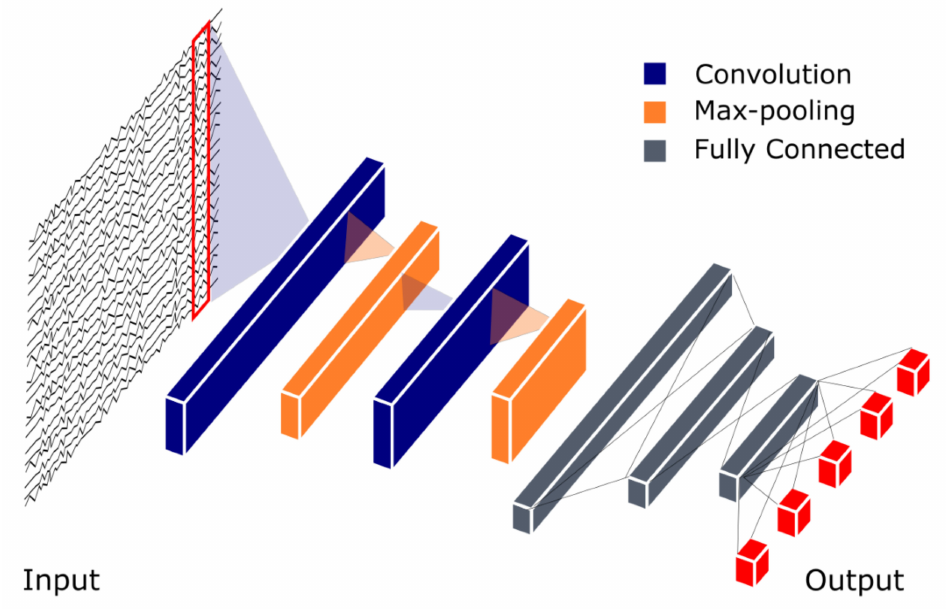
Figure 2. Basic Convolutional Neural Network (CNN) model architecture for polysomnogram (PSG) recording analysis. The CNN output model is represented by five red boxes indicating five prediction classes for example W (Wakefulness), S1–S3 (Non-REM sleep Stages 1–3) and REM (rapid eye movement)